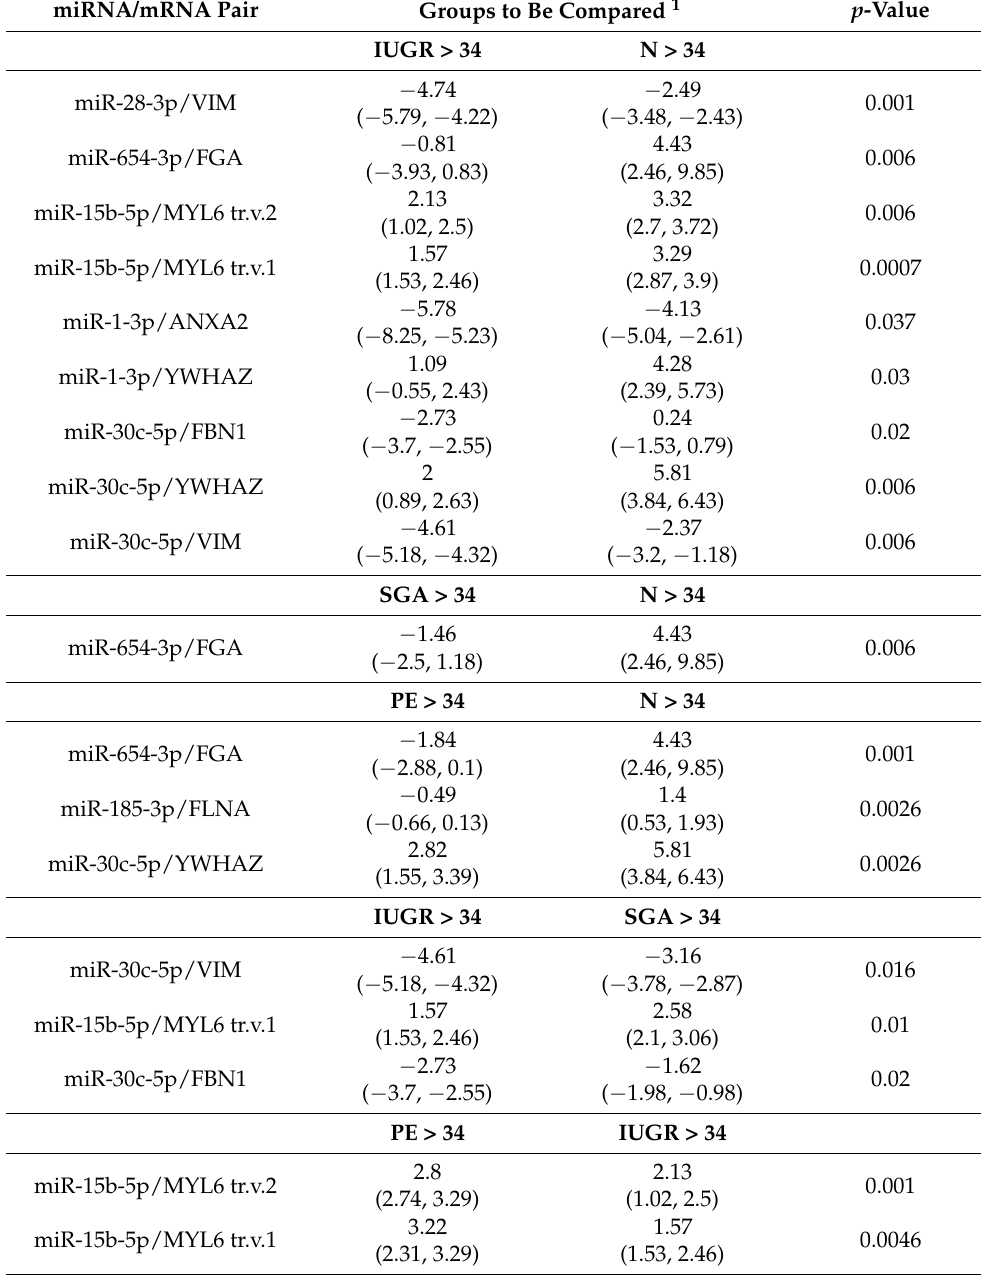
Table 4. Pairwise comparison of the IUGR, PE, SGA, and N groups by the expression level ratio of miRNA and its target gene, obtained by RT-PCR in each of the studied placental bed samples. miRNA/mRNA Pair Groups to Be Compared 1 p -Value IUGR > 34 N > 34